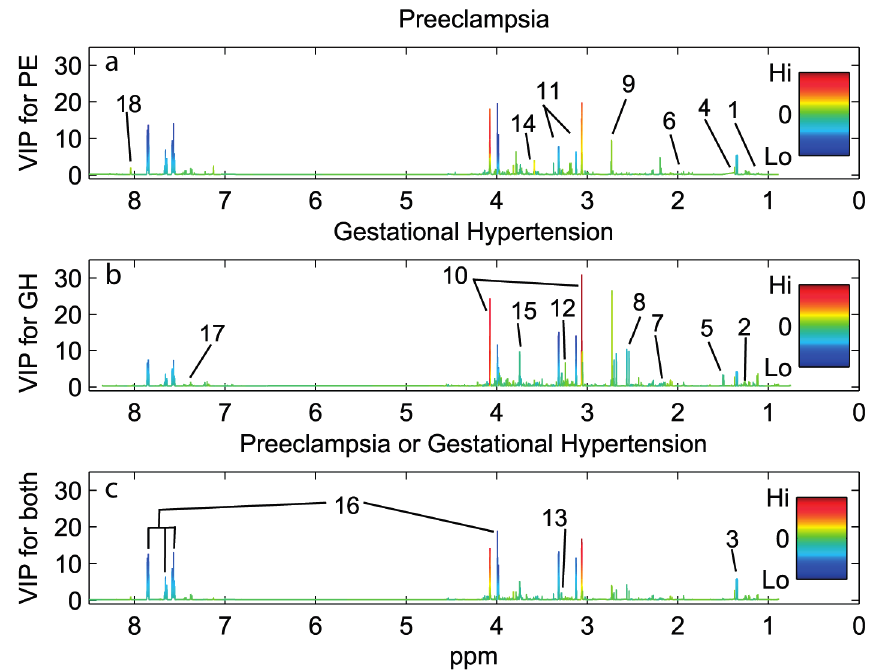
Figure 2. Urine 1 H NMR variables involved in predicting preeclampsia (PE), gestational hypertension (GH) and both combined using partial least squares discriminant analysis (PLS-DA). The variable importance in projection (VIP) scores for each variable (part per million, ppm) are shown on the vertical axis, with higher VIP scores meaning increasing importance in the predictive model. The variables are colored by the loadings from the corresponding PLS-DA model. Red means increasing levels of metabolite in the indicated condition and blue meaning decreasing levels. Metabolites by